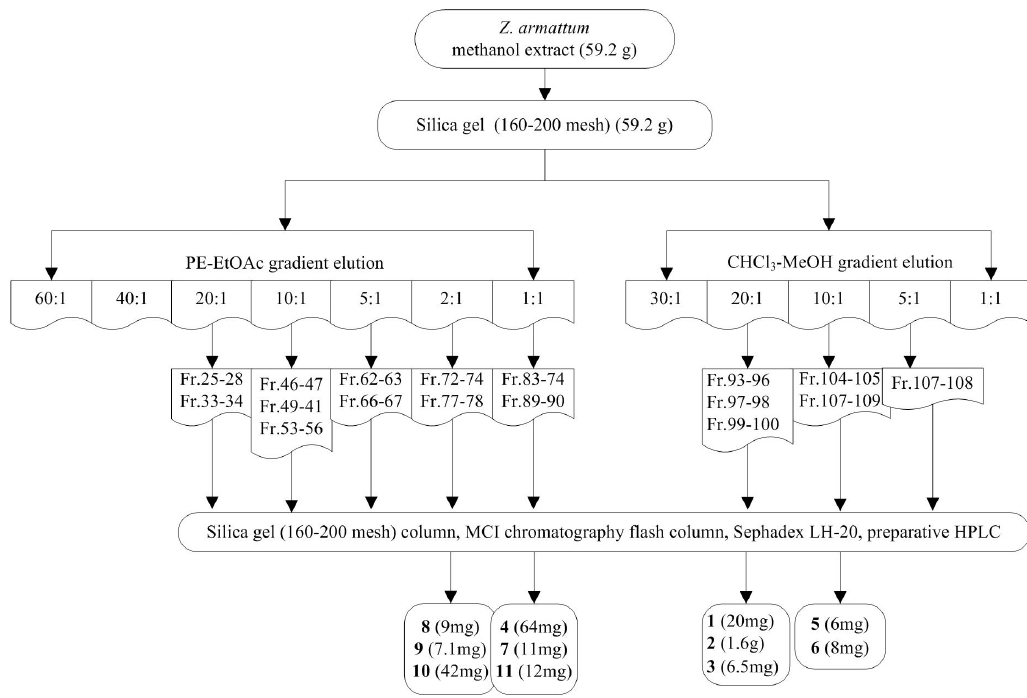
Figure 3. Chemical isolation scheme of Zanthoxylum armatum methanol extract.